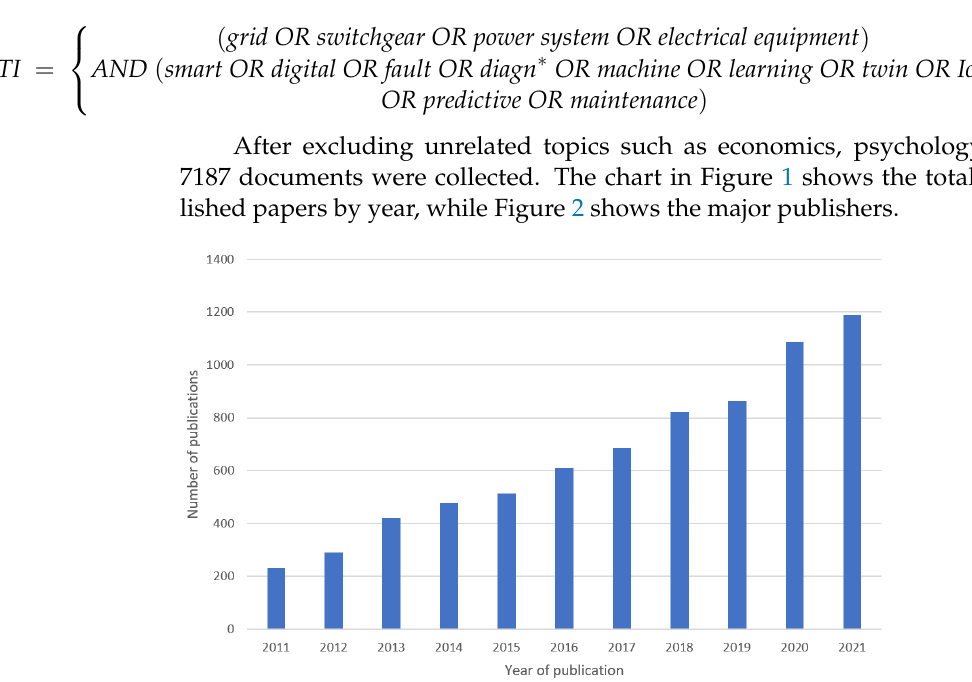
Figure 1. Number of publications related to the research topic in the past decade.